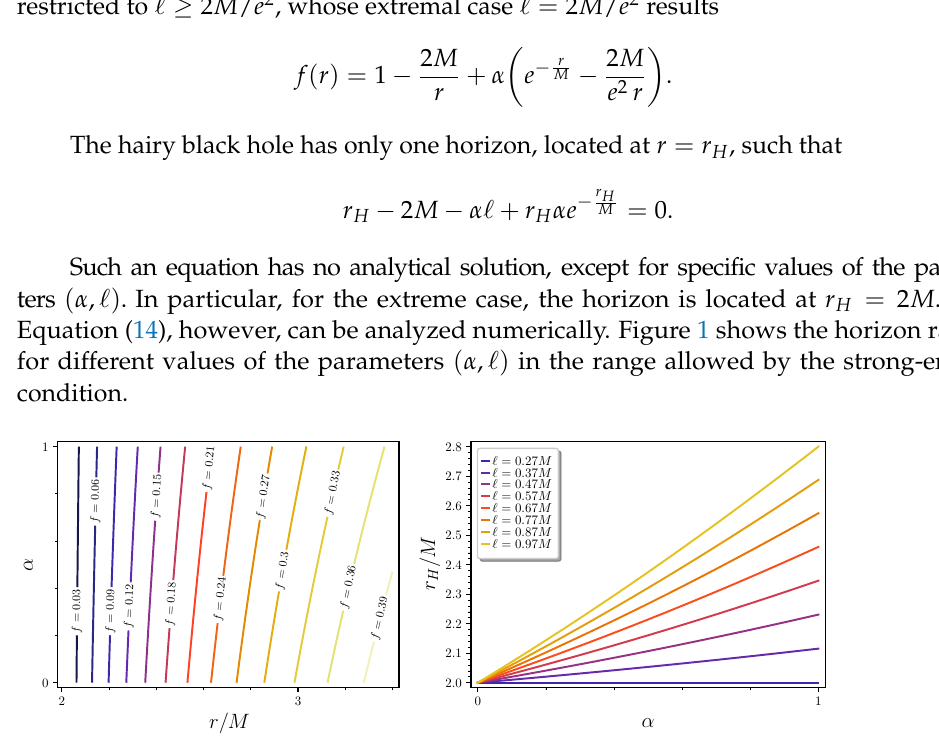
Figure 1. Left panel: Contour lines of f ( r ) depending on ( r , α ) for the extreme case ( (cid:96) = 2 Me − 2 ). Right panel: Radius of the hairy black hole horizon r H as function of α for different values of the parameter (cid:96) . The non-linearity of Equation (14) has little influence on r H